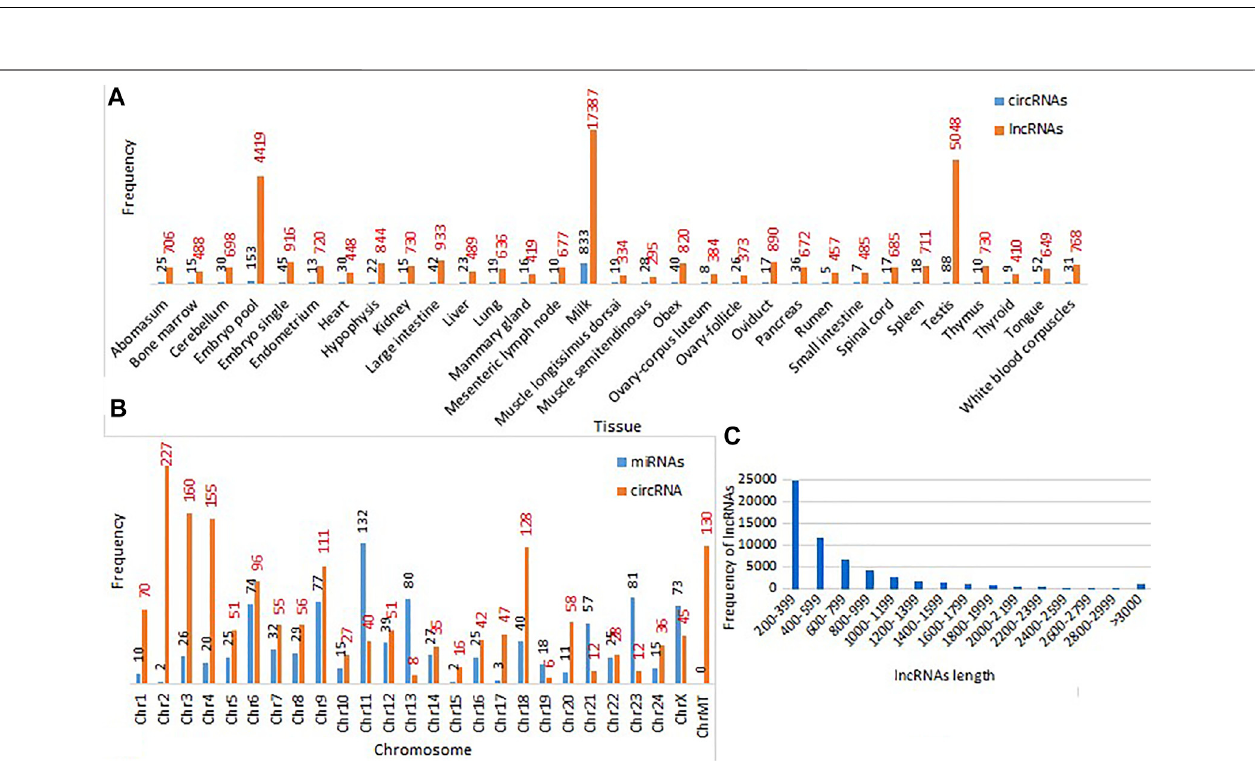
FIGURE 4 | (A) Tissue-wise frequencies of circRNAs and lncRNAs (B) chromosome-wise frequencies of miRNAs and circRNAs; (C) length-wise frequencies of lncRNAs in buffalo.